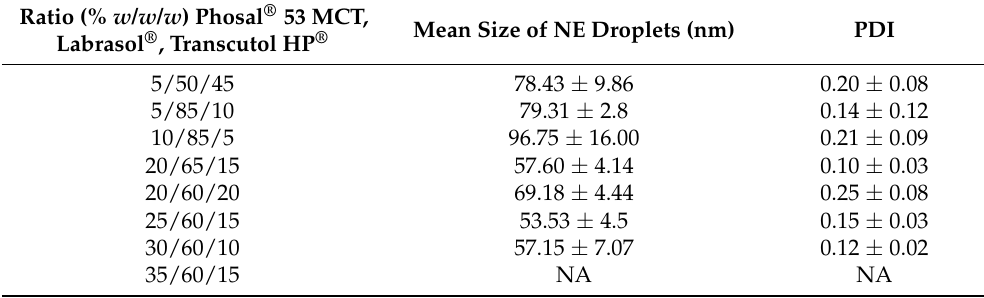
Table 3. Influence of excipient ratio on mean size of NE (SNEDDS diluted in water at 1:1000, n = 3). Ratio (% w / w / w ) Phosal ® 53 MCT,